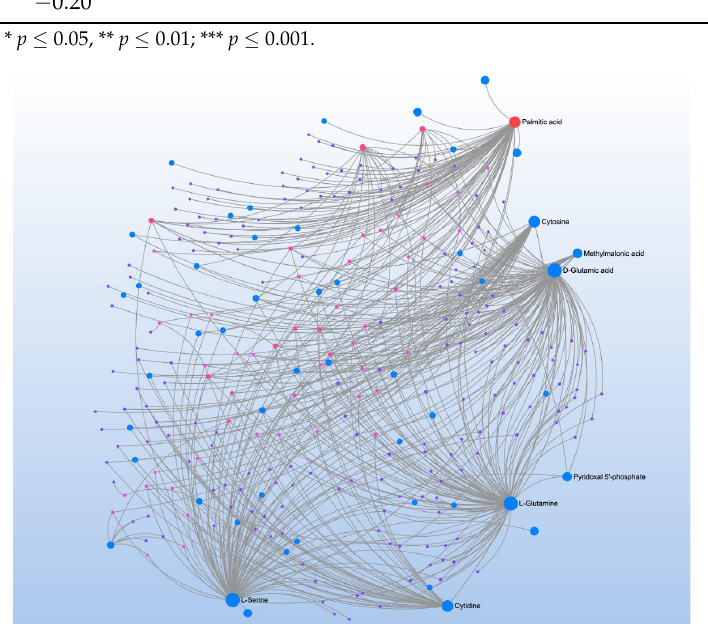
Figure 12. Metabolite-metabolite interaction network for significant metabolites that correlate to 3-nitrotyrosine, a biomarker of oxidative protein damage. Size of the node indicates importance in the network. The interaction analysis highlights the importance of amino acid neurotransmitter metabolism, particularly glutamine